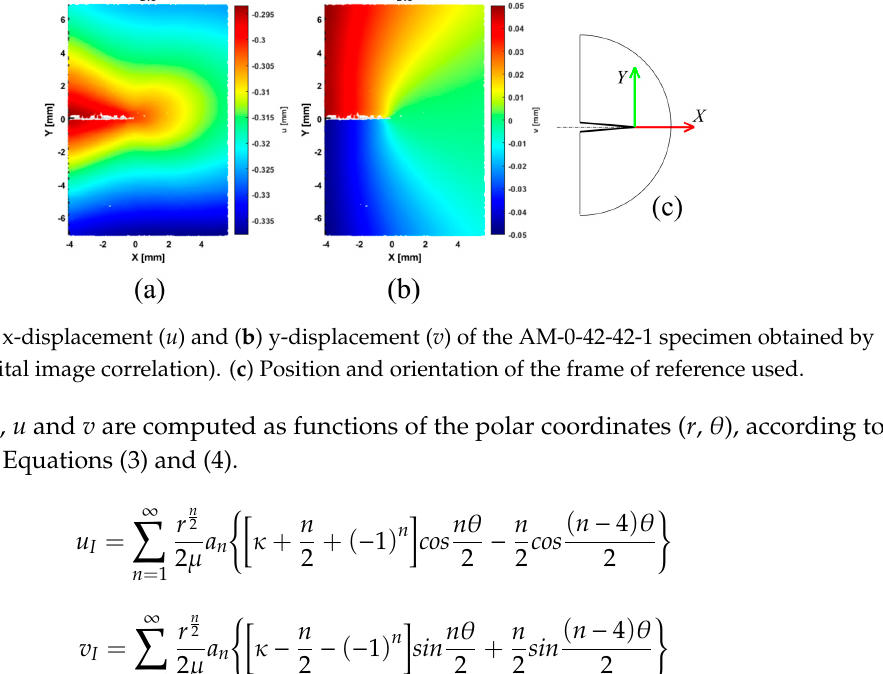
For Mode II, u and v are computed as functions of the polar coordinates ( r , θ ), according to the